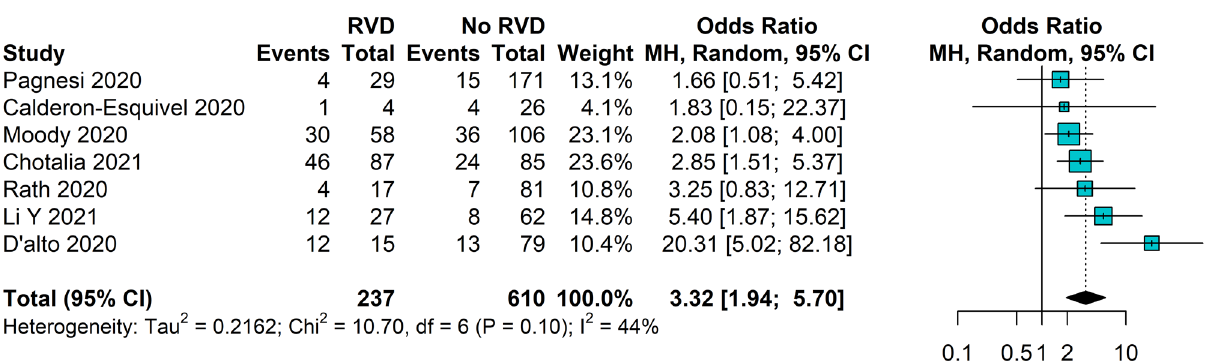
Figure 3. All-cause death according to RVD status in patients with COVID-19. CI confidence intervals; RVD right ventricular